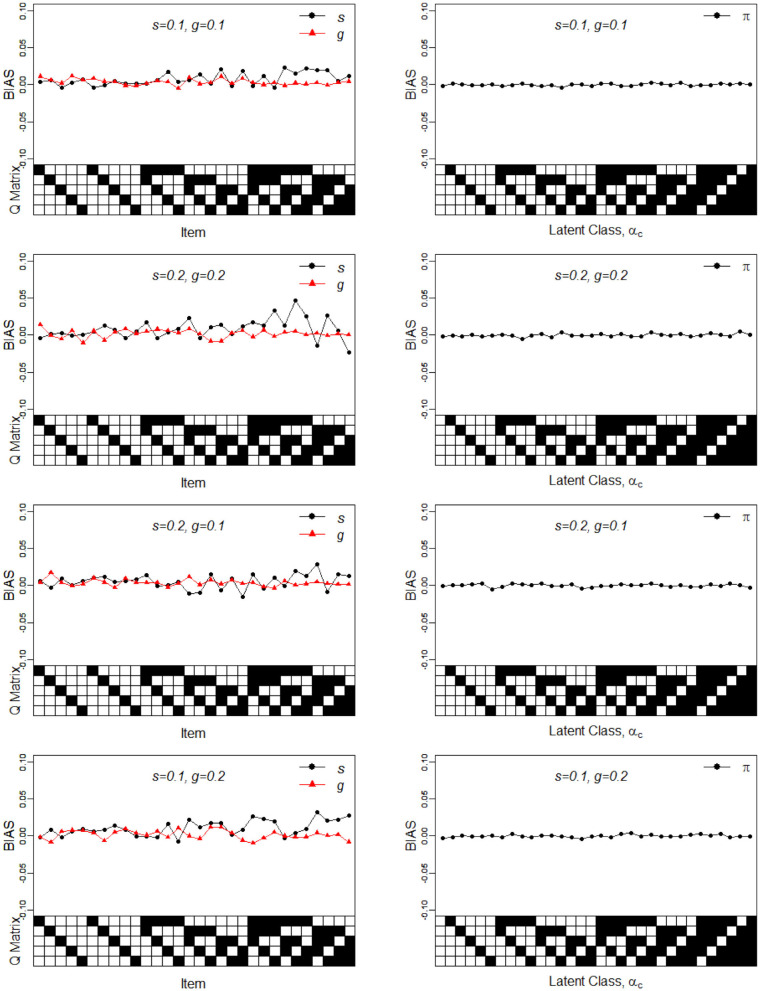
Bias of the slip, guessing, and the latent membership parameters under four different noise levels. Given on the X-axis are the Q-matrix and αc, where a black square denotes the presence of the attribute.